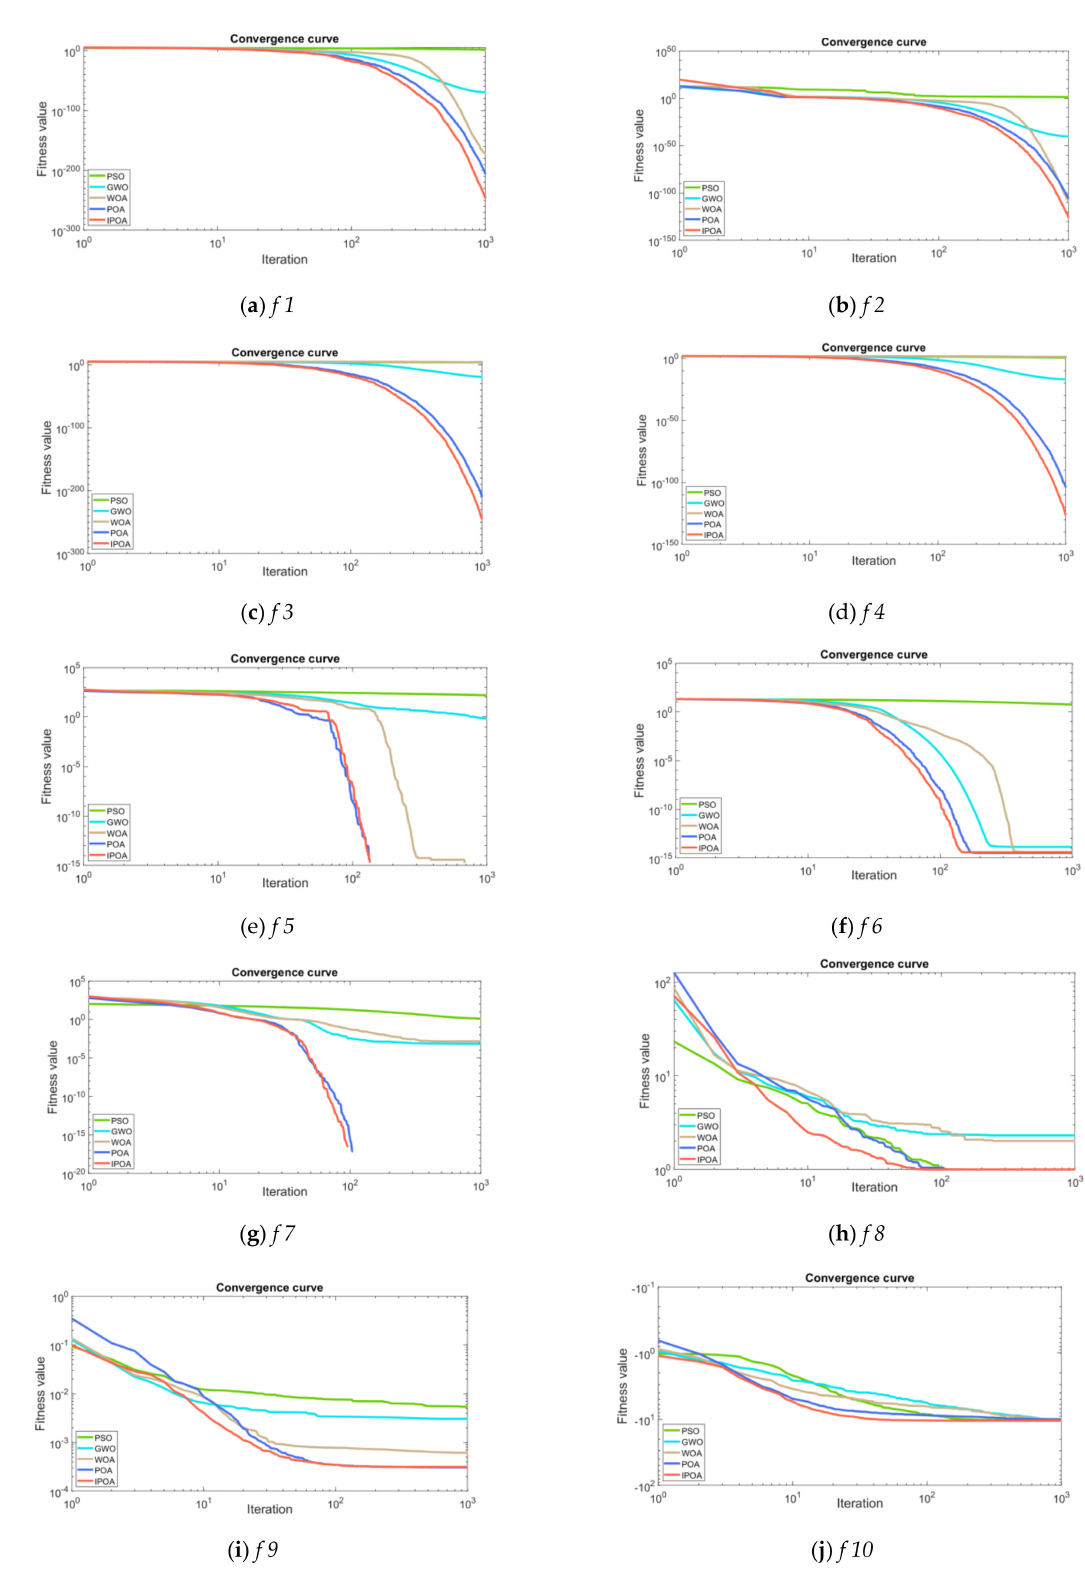
Figure 4. The convergence curves of benchmark